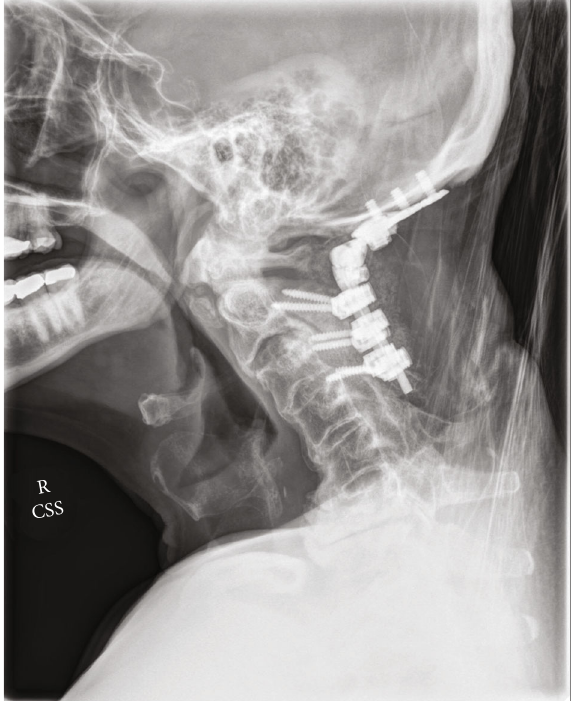
Figure 4: Postoperative lateral cervical spine X-ray demonstrates occipitocervical fusion with a C2-C4 lateral mass screw and posterior rod construct with the occipital plate.